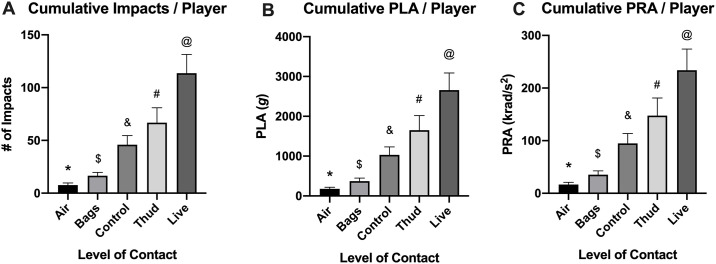
Cumulative head impact kinematics between levels-of-contact throughout a season.Cumulative (A) head impact count, (B) peak linear acceleration, and (C) peak rotational acceleration per player was influenced by the level-of-contact in an incremental manner, with live being the highest and air being the lowest. Data are presented as mean ± SD. Bonferroni post-hoc results are listed below: please refer to S1 Table for exact p-values of all possible comparisons. Please refer to S2 Table for median (IQR) values of head impact kinematics. @ Live is greater than thud (p = 0.045), control (p<0.001), bags (p<0.001) and air (p<0.001). # Thud is lesser than live (p = 0.045), no difference from control (p = 0.095), and greater than bags (p = 0.013) and air (p = 0.008). & Control is lesser than live (p<0.001), no difference from control (p = 0.095), and greater than bags (p = 0.008) and air (p = 0.003). $ Bags is lesser than live (p<0.001), thud (p<0.01), and control (p = 0.008), and greater than air (p = 0.041). * Air is lesser than live (p<0.001), thud (p = 0.007), control (p = 0.003), and bags (p = 0.041).